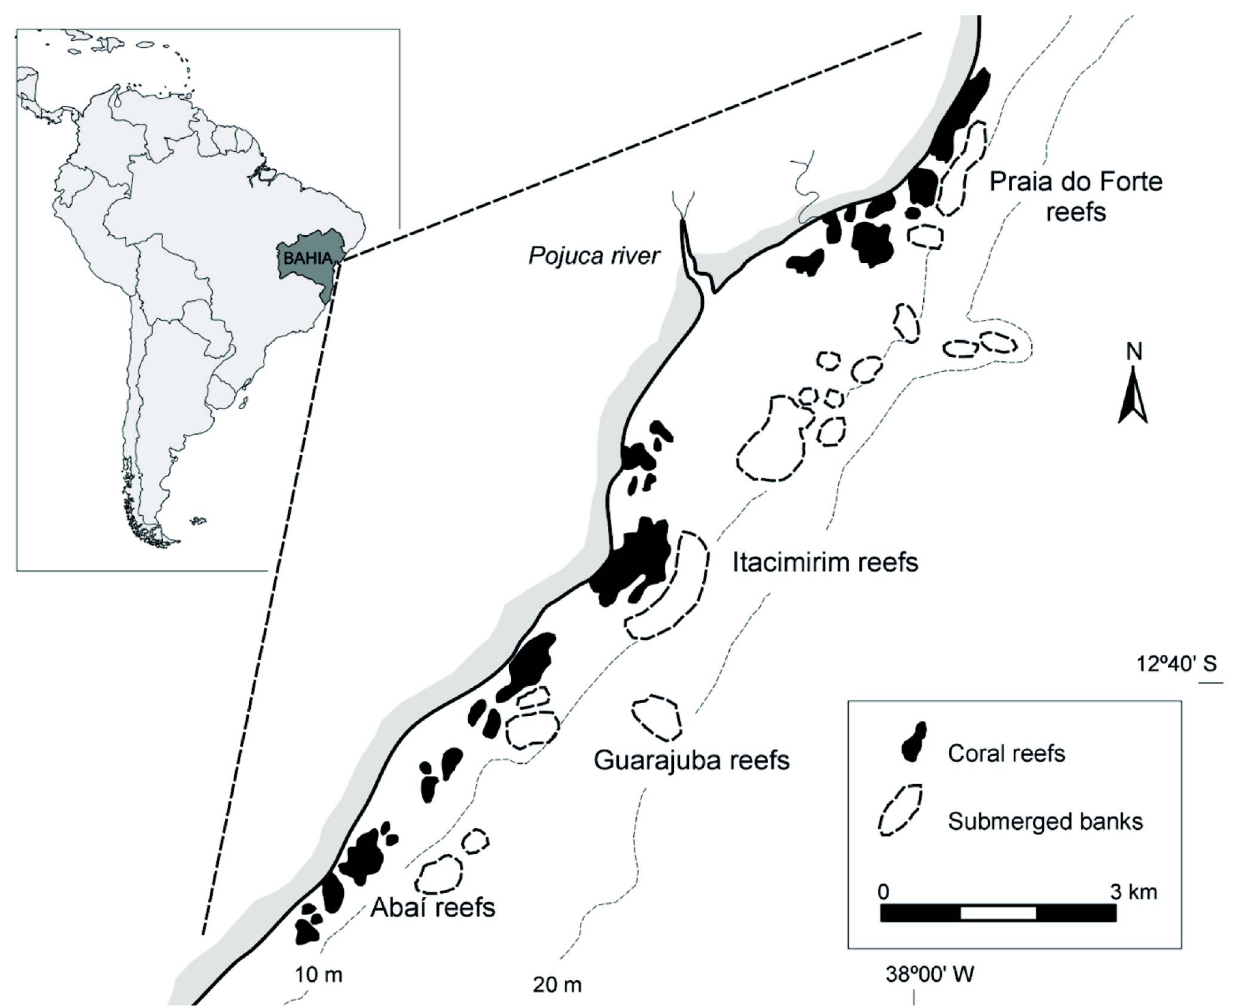
Figure 1. The location of the coral reefs of northern Bahia (After Lea˜o etal ., 1997).